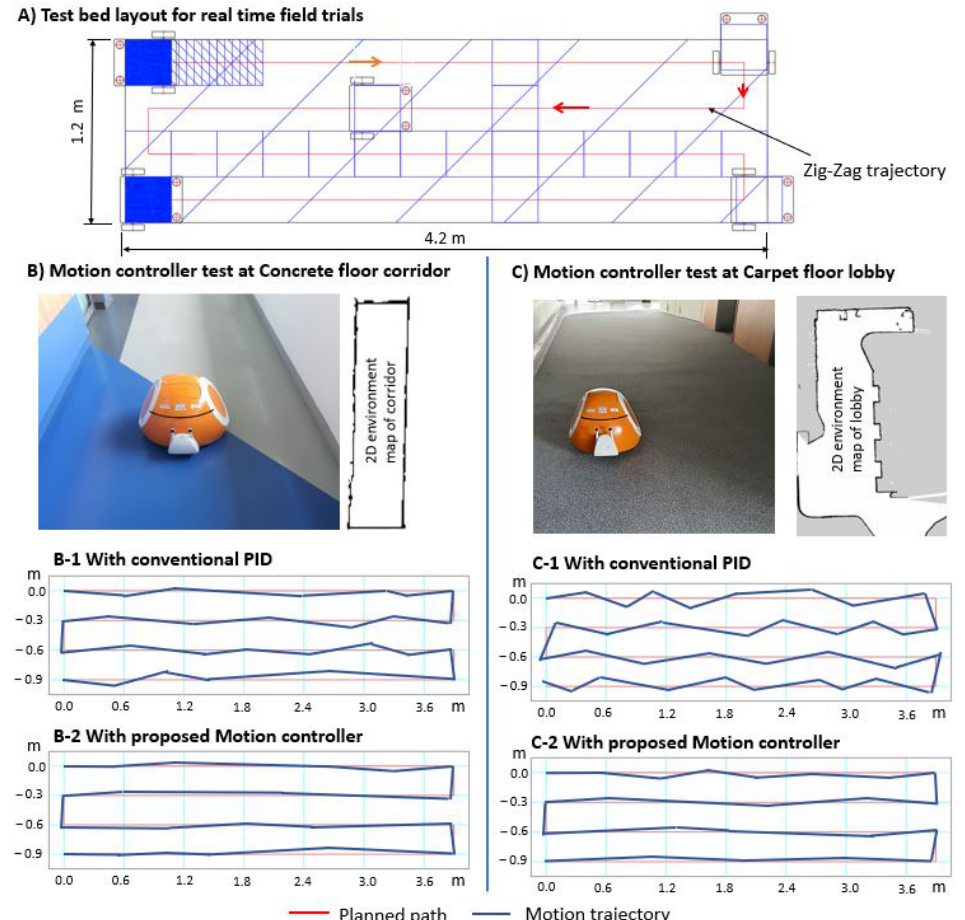
Figure 11. Autonomous traverse test following trajectory with motion controller design.